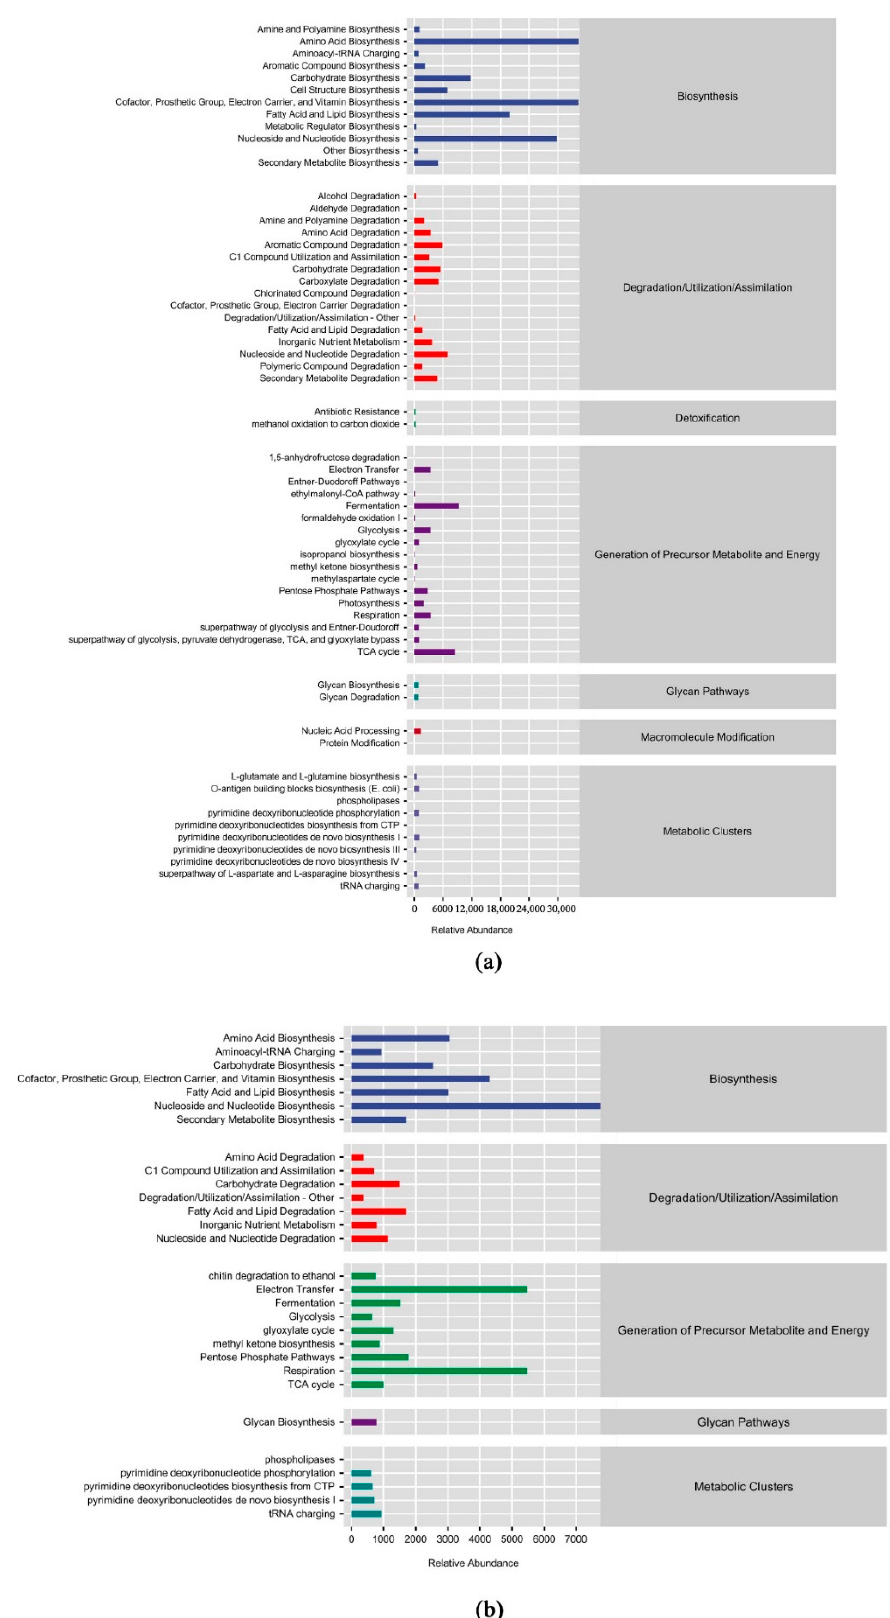
Figure 10. Metabolic pathway statistics of microbial communities with different leaf litter ratios. ( a ): litter bacterial communities; ( b ): litter fungal